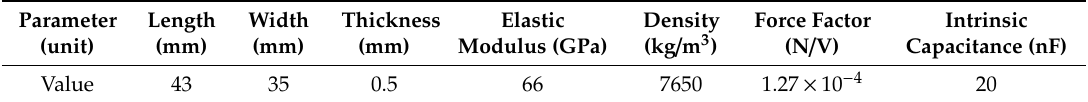
Table 2. Parameters of the piezoelectric patch.